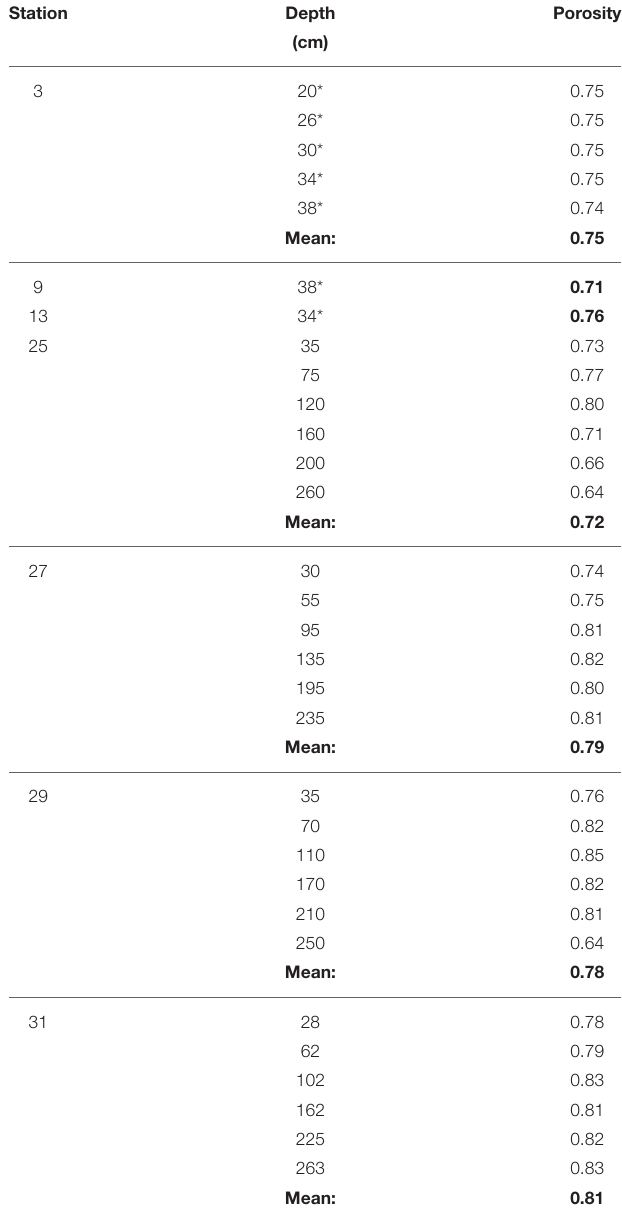
TABLE 2 | Gravity core